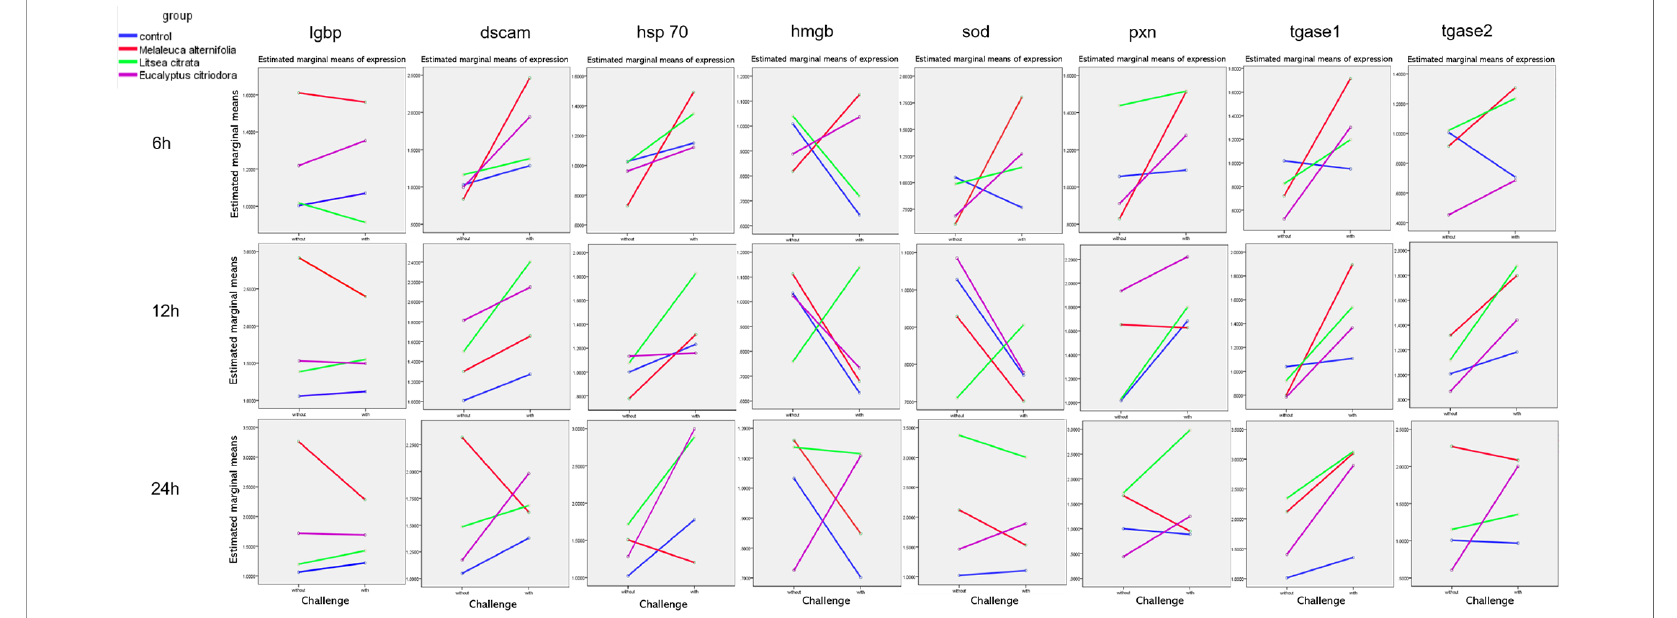
FIGURE 4 | The interaction plots between relative expression of lgbp , dscam , hsp 70, hmgb , sod , pxn , tgase 1 , and tgase 2 genes in Artemia larvae treated with EO of Melaleuca alternifolia , Litsea citrata , Eucalyptus citriodora , and the control group when challenged with/without Vibrio campbellii BB120, respectively, according to the output from two-way ANOVA. Control group: no EO added but consisted of 1% of